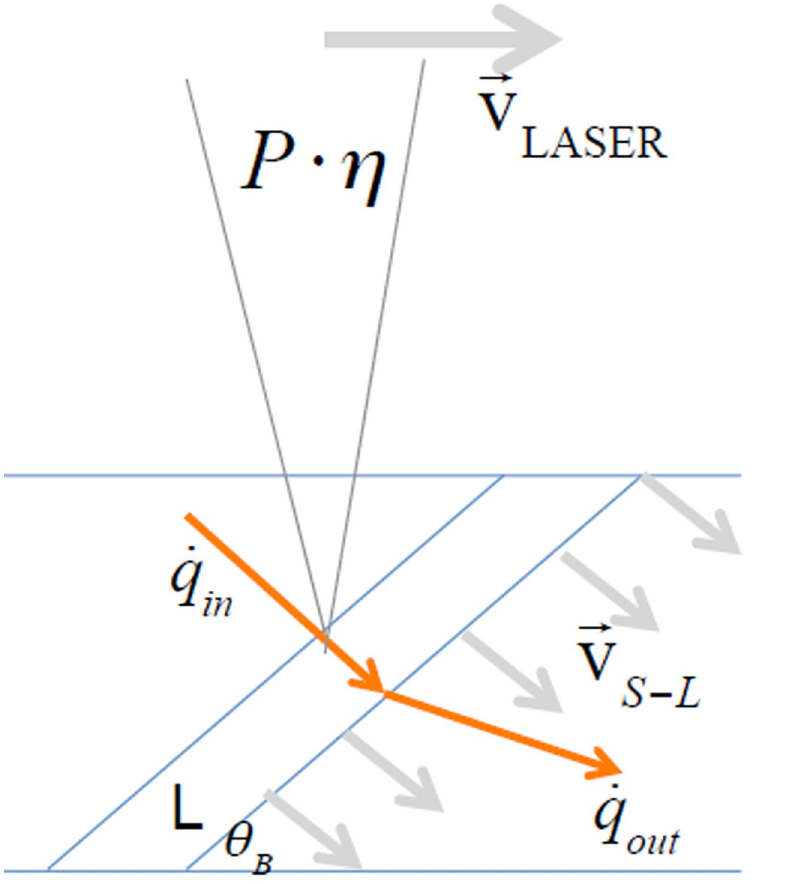
Fig 1. Representation of laser cutting dynamics process in a material.